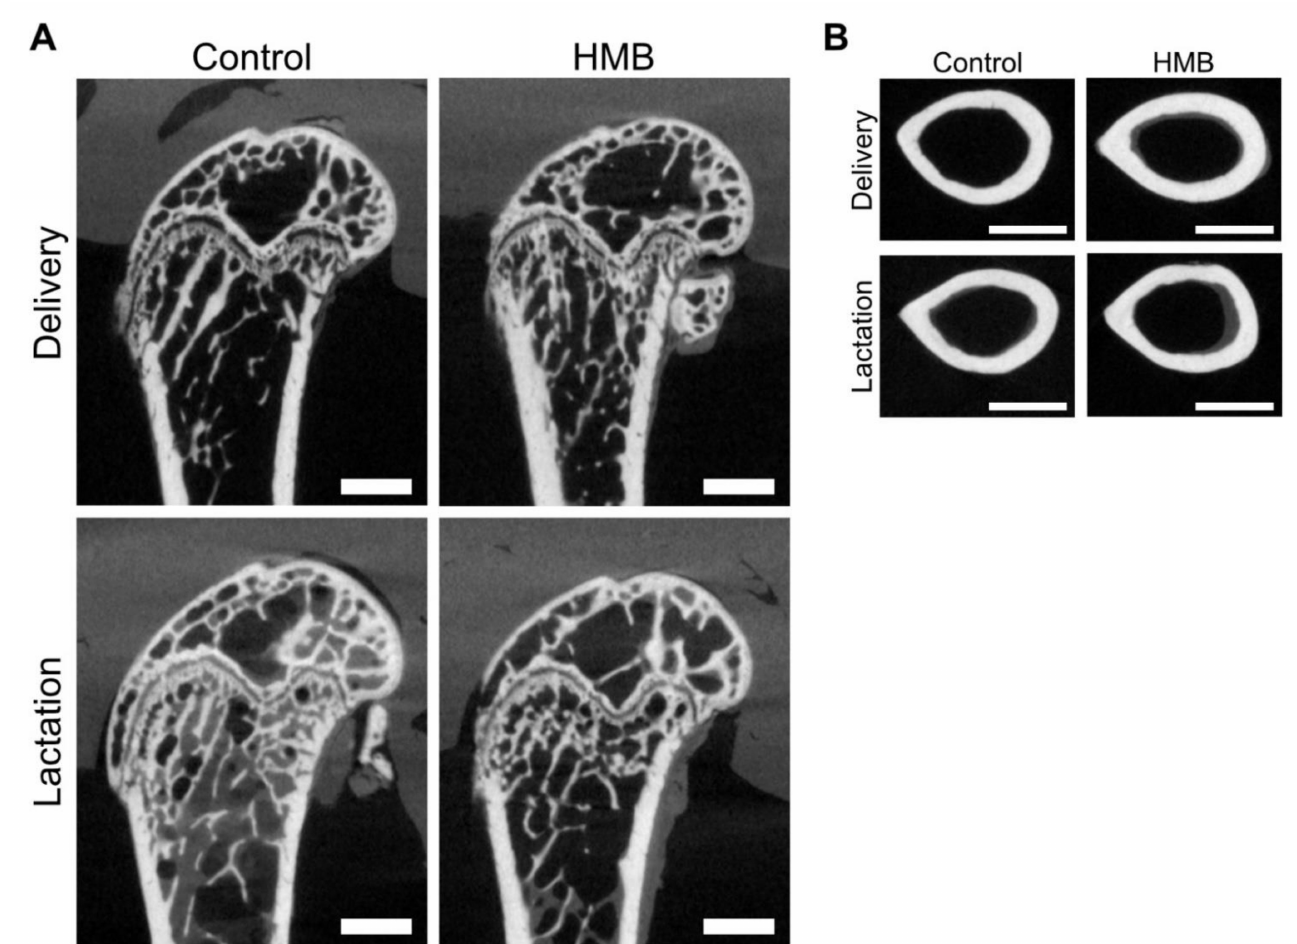
Figure 2. Representative µ CT images of sagittal sections of the femur distal diaphysis ( A ) and transverse sections of the femur mid-diaphysis ( B ) from pregnant female controls (not receiving HMB) at delivery (CONT-D) or after the lactation period (CONT-L) and from pregnant HMB females (receiving HMB at a dose of 0.02 g/kg b.w. during the middle trimester of pregnancy) at delivery (HMB-D) or after the lactation period (HMB-L). Scale bars represent 1000 µ